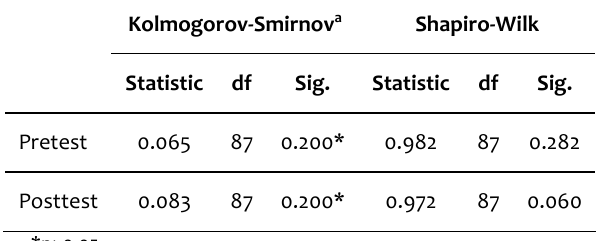
Table 3. Ecological footprint awareness scale normality distribution